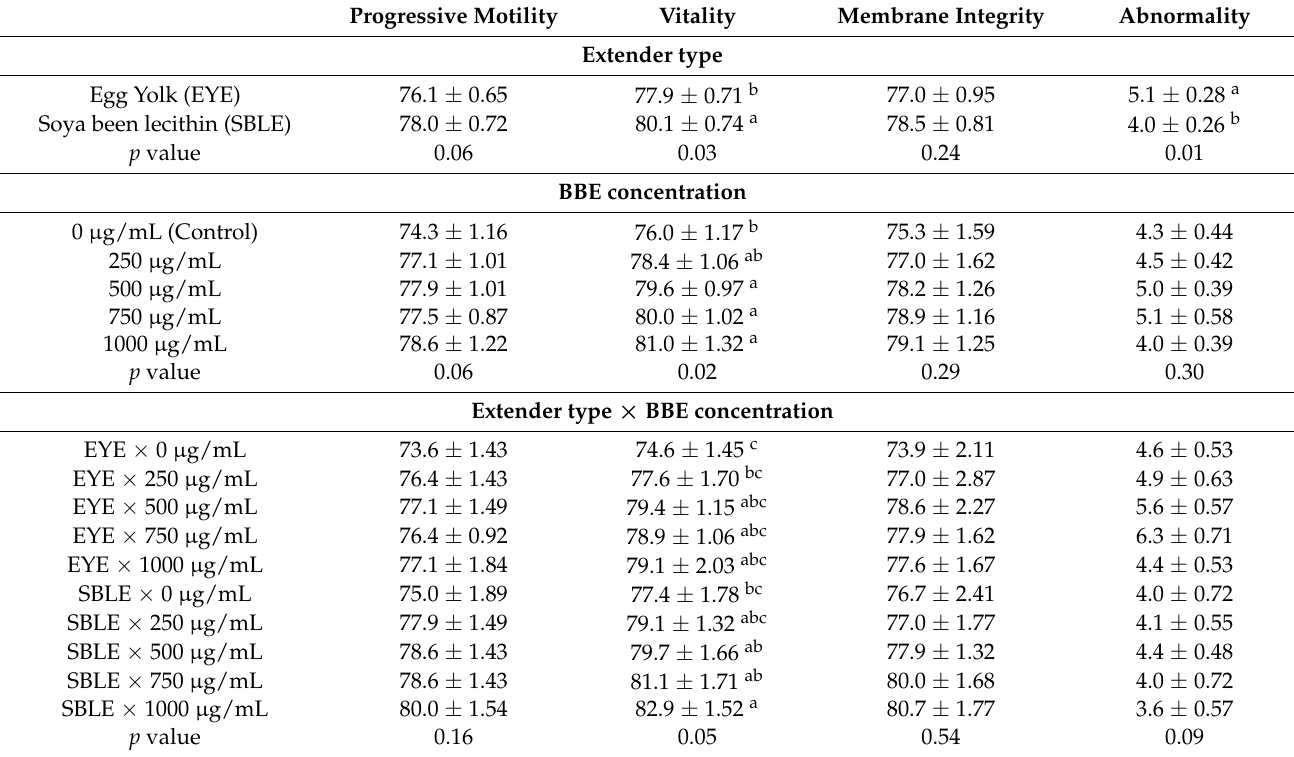
Table 2. Effects of the extender type, bee bread extract (BBE) concentration, and their interaction on the proportion (%) of ram sperm characteristics after equilibration at 5 ◦ C for 4 h. Progressive Motility Vitality Membrane